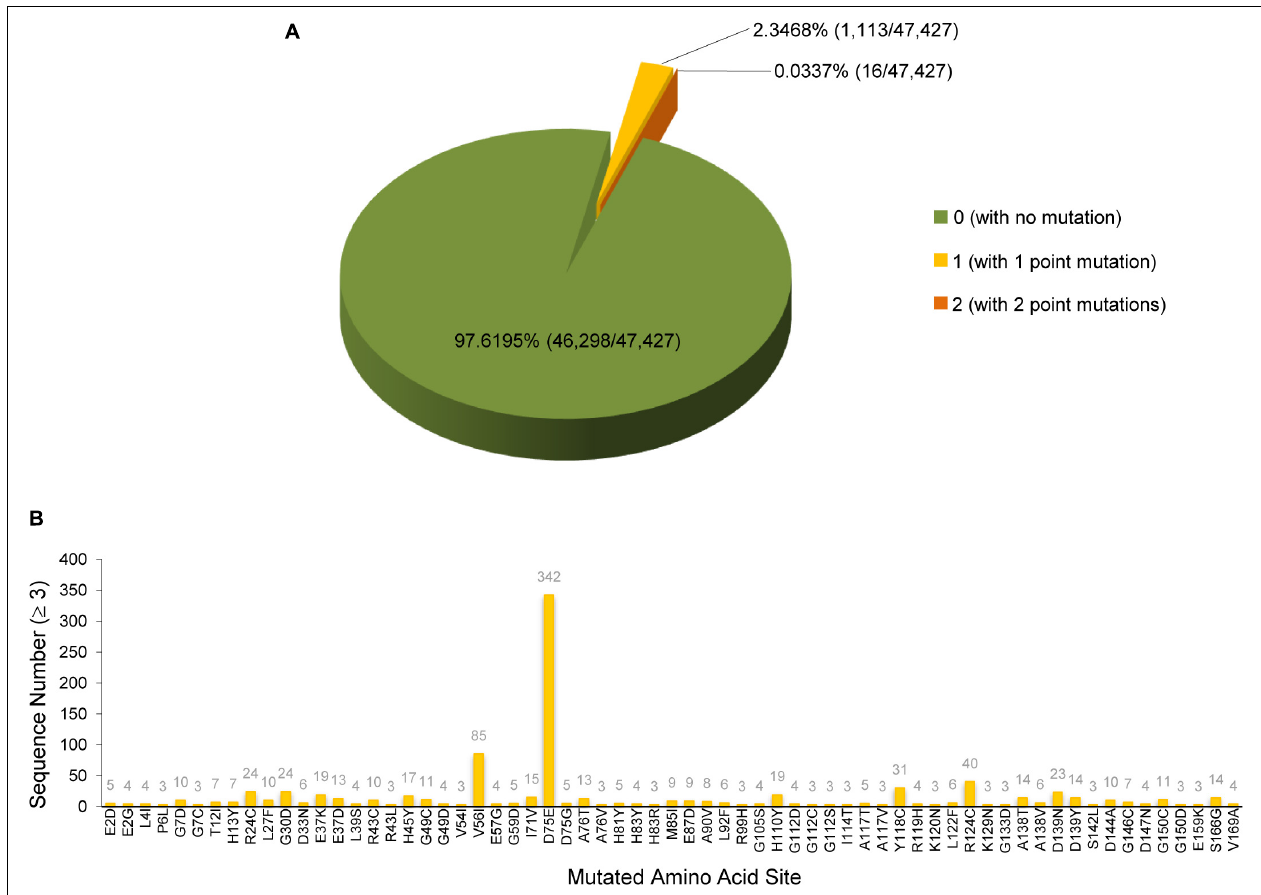
FIGURE 1 | SARS-CoV-2 nsp1 sequence analysis. SARS-CoV-2 genomic sequences of high quality (47,427 in total) were collected from the GISAID database. Sequence alignment was performed using the EMBOSS diffseq program with the strain Wuhan-Hu-1 as the reference. According to the alignment, the nsp1 region was found to be highly conservative. Most of the nsp1 sequences are identical to that of the Wuhan-Hu-1 strain without any mutation. Only a few nsp1 protein sequences (1,129 of the analyzed 47,427 sequences) have one or two point mutations, compared to the reference strain. The detailed numbers and ratios of the nsp1 protein sequences with or without mutation were displayed in panel (A) . The identified mutation sites and the numbers ( ≥ 3) of the sequences harboring the indicated point mutation were summarized in panel (B) . Note that most of the mutations were found in only one or two sequences and are not shown in panel (B) . See also Supplementary Table S1 and the descriptions in the